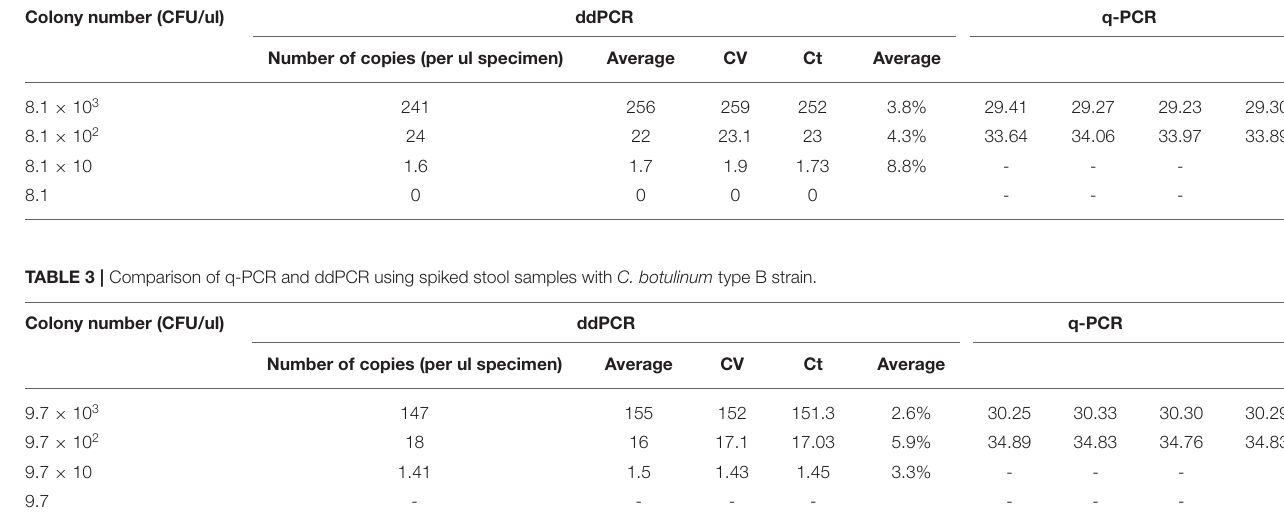
TABLE 2 | Comparison of q-PCR and ddPCR using spiked stool samples with C. botulinum type A strain. Colony number (CFU/ul)